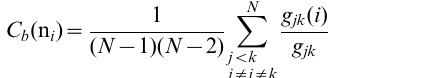
residue annotation as described in Figure 2. For clarity of presentation, the equilibrium profiles are shown only for one monomer of the homodimer. Figure S2 The Force Constant Stability Analysis of the Grp94 Chaperone. (A) The residue-based force constant profile of the ATP-bound Grp94 chaperone structure. The NTD